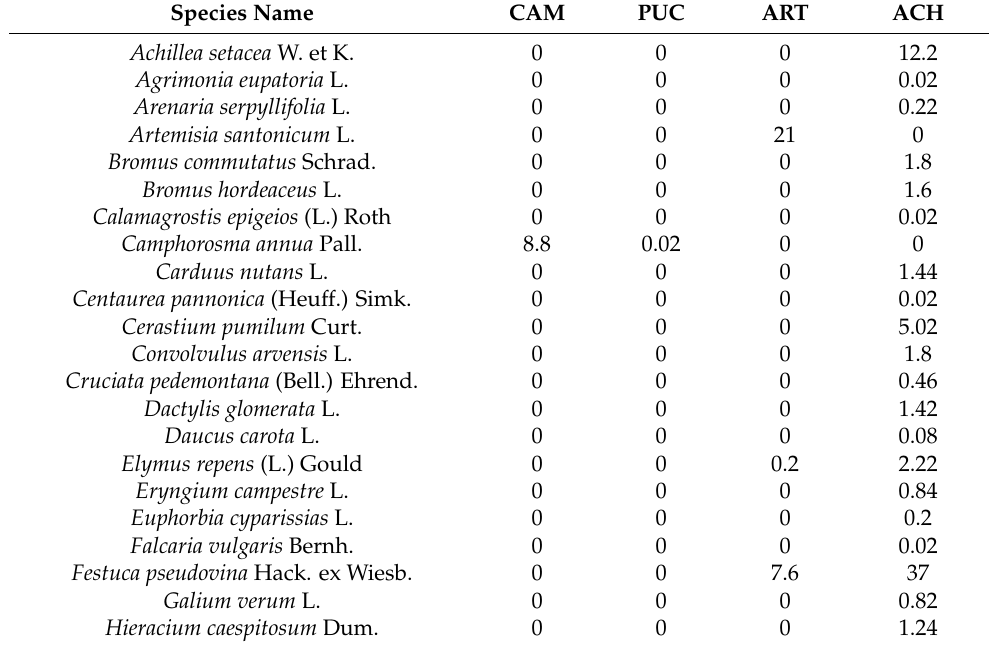
Table A2. Species composition of the four salt-affected vegetation types, studied at Apaj, Hungary. Numbers are percentage cover values for each species calculated as the average of its cover